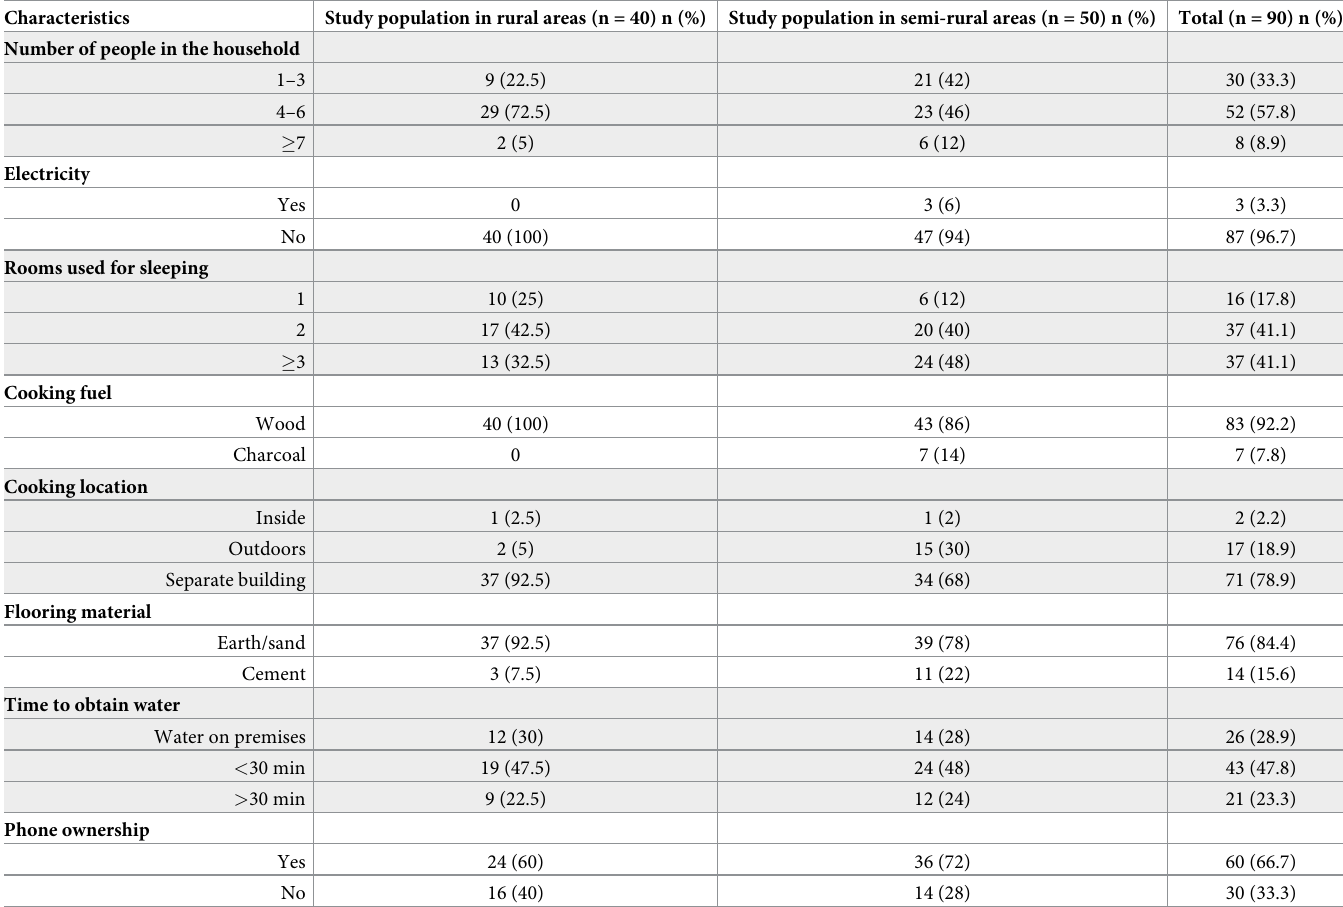
Table 3. Household characteristics of informants.